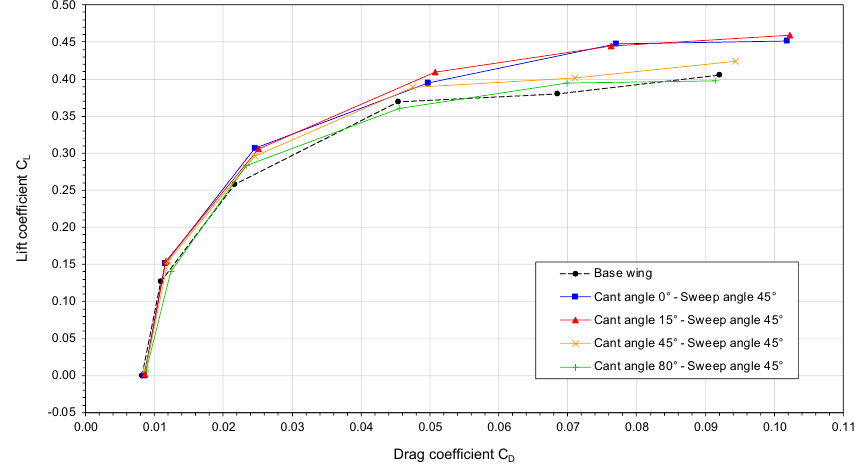
Figure 12. Drag polar at Mach number 0.8395, winglet sweep angle 45 ◦ and different values of cant